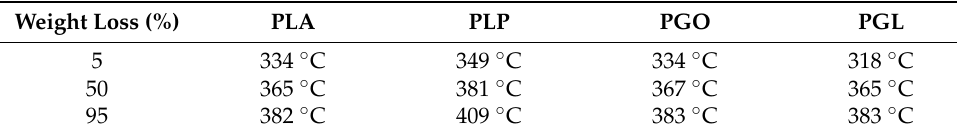
Figure 4. Thermogravimetric analysis of PLA, PLP, PGO, and PG. Effect of temperature on the weight loss from 25 to 800 ◦ C ( a ) and effect of time at a constant temperature of 170 ◦ C ( b ). The average of three experiments is represented. Table 8. Temperature of decomposition at 5, 50, and 95% weight loss.